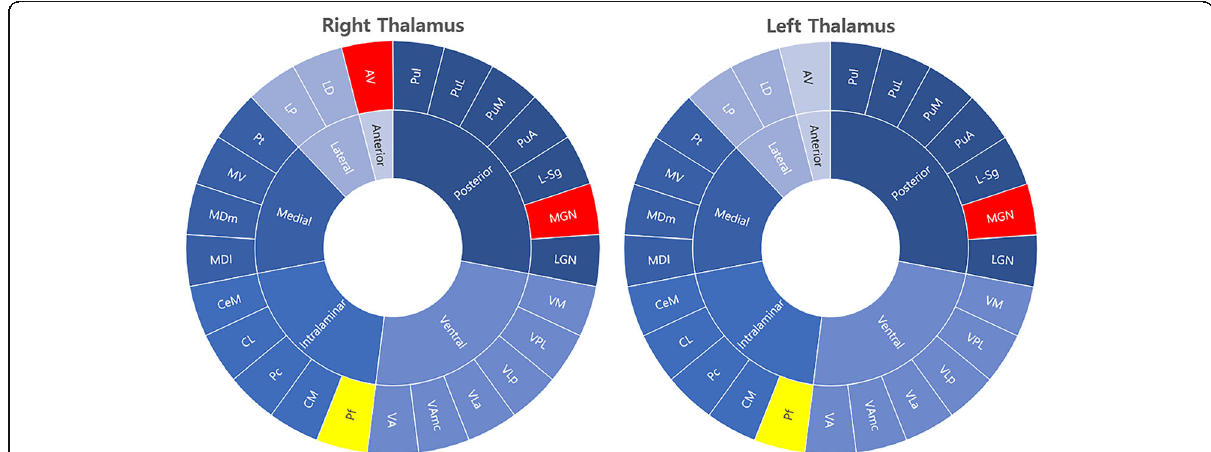
Fig. 2 Thalamic nuclei with significant volume alterations in patients with migraineRegions in red represent increased volumes and regions in yellow reveal decreased volumes in patients with migraine as compared with healthy controls. The figure shows that the right anteroventral and right and left medial geniculate nuclei volumes are increased, whereas the right and left parafascicular nuclei volumes are decreased in patients with migraine. AV: anteroventral, LD: laterodorsal, LP: lateral posterior, VA: ventral anterior, VAmc: ventral anterior magnocellular, VLa: ventral lateral anterior, VLp: ventral lateral posterior, VPL: ventral posterolateral, VM: ventromedial, CeM: central medial, CL: central lateral, Pc: paracentral, CM: centromedian, Pf: parafascicular, Pt: paratenial, MV: medial ventral, MDm: mediodorsal medial magnocellular, MDl: mediodorsal lateral parvocellular, LGN: lateral geniculate, MGN: medial geniculate, L-Sg: suprageniculate, PuA: pulvinar anterior, PuM: pulvinar medial, PuL: pulvinar lateral, Pul: pulvinar inferior